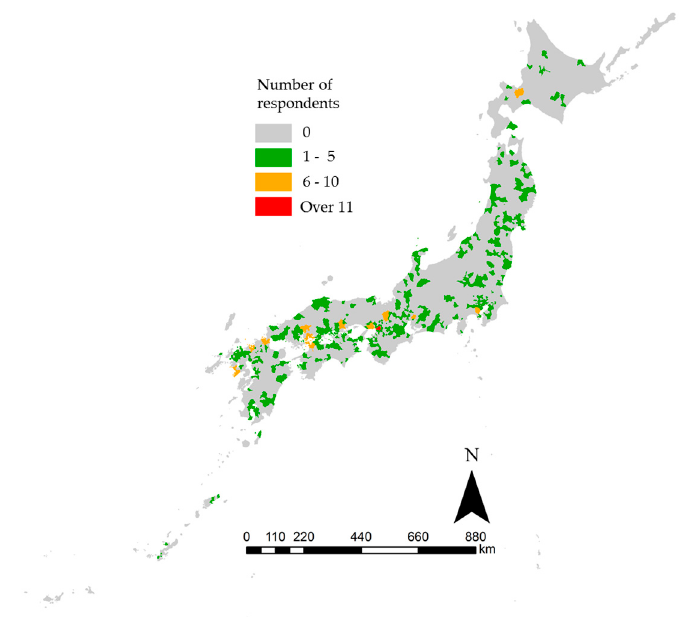
Figure 2. The spatial distribution of respondents’ hometowns by municipal unit.